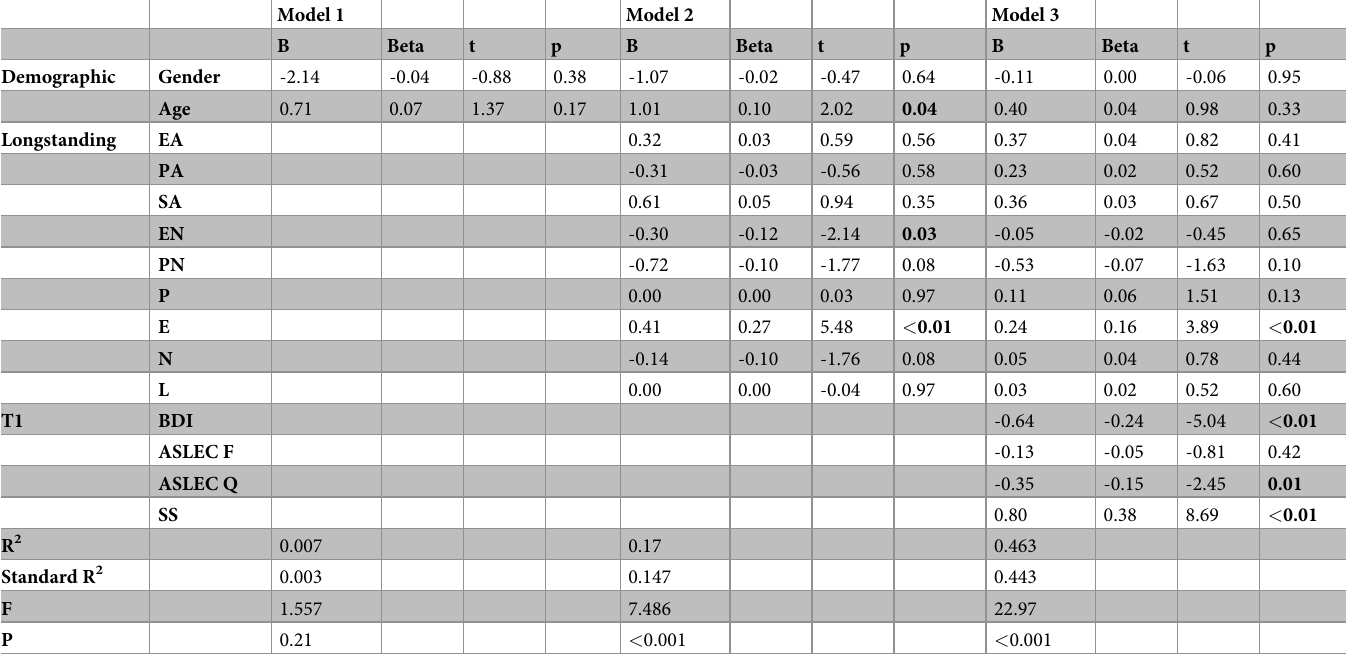
Table 3. Hierarchical linear regression for T1